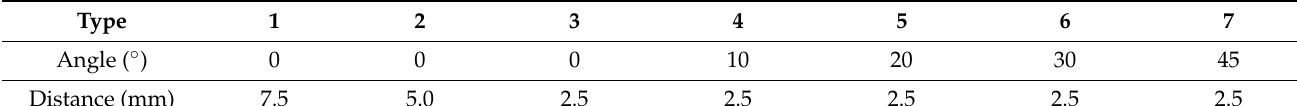
Table 3. Seven film metamaterials with different mass distribution parameters: Types 1–3 explore the influence of the distance between the centroids; Types 3–7 explore the possible influence of the different included angles between the two centroids.